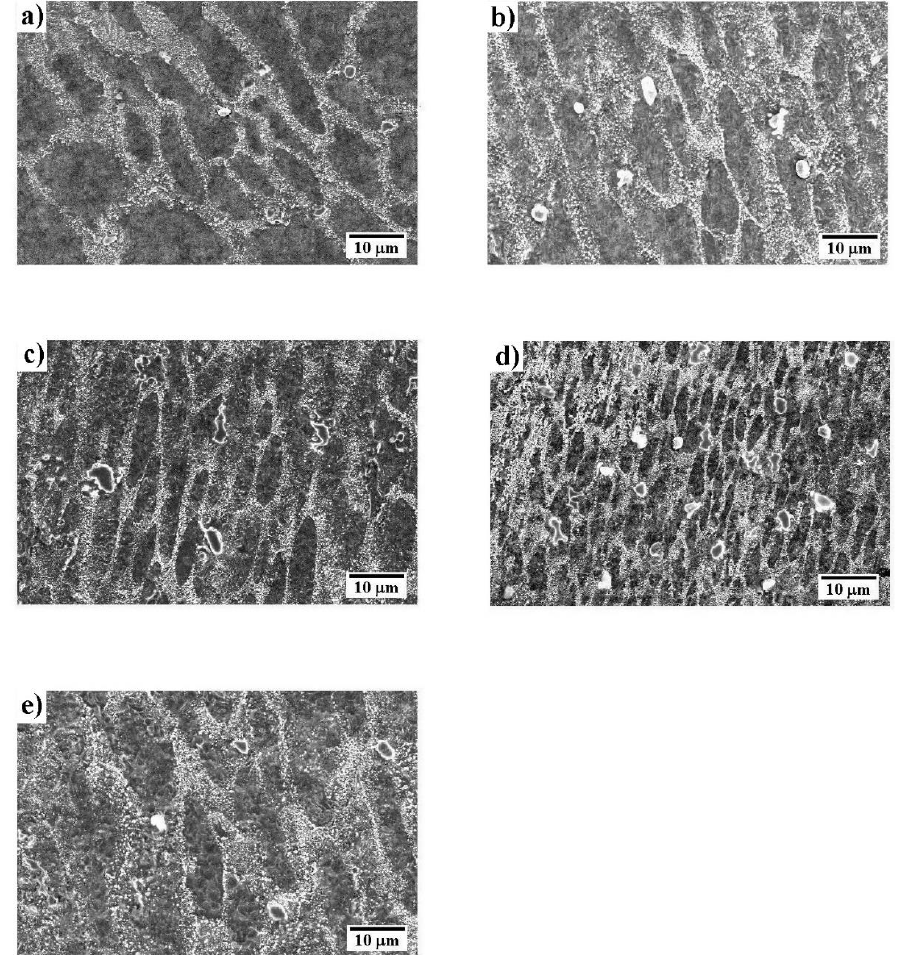
Figure 7. Representative SEM micrographs of the SAC105-Bi solders aged at 353 K ( a ) SAC105, ( b ) SAC105-0.5Bi, ( c ) SAC105-1.5Bi, ( d ) SAC105-2.5Bi, and ( e ) SAC105-3.5Bi solders. When 3.5Bi was added into the SAC105 solders, the steady-state creep rate values were found to increase abnormally (see Figure 2). These unusual observations may be elucidated as follows. The growth of larger particles at the smaller particles' expense with a higher interfacial enthalpy is known as Ostwald ripening. The process's driving force diminishes the total interface area between the dispersed particles and the matrix. De- pending on the particle size variation, the free energy of a particle alters. This alteration leads to solubility variation at the particle/matrix interface (Gibbs–Thomson effect). The result is that the matrix surrounding the larger particles contains less solute than the ma- trix area around smaller particles, which sets up solute concentration gradients in the di- rection of the smaller particles to the larger particles. Consequently, the smaller particles shrink, and the larger particles grow, even while the particles' overall volume fraction is still invariable [34,35]. The 3.5Bi addition elevates the size and spacing between Ag 3 Sn and Cu 6 Sn 5 precipitates, which are still smaller for the Bi-free solders (Figure 7e). These obser- vations may be referred to the Bi rich phase accumulation in the β-Sn matrix. Figure 8 exhibiting the microstructure of the SAC105 solder containing 3.5Bi. A magnified view disclosed in Figure 8a showing the distribution of the Bi-rich phase within the β-Sn matrix.